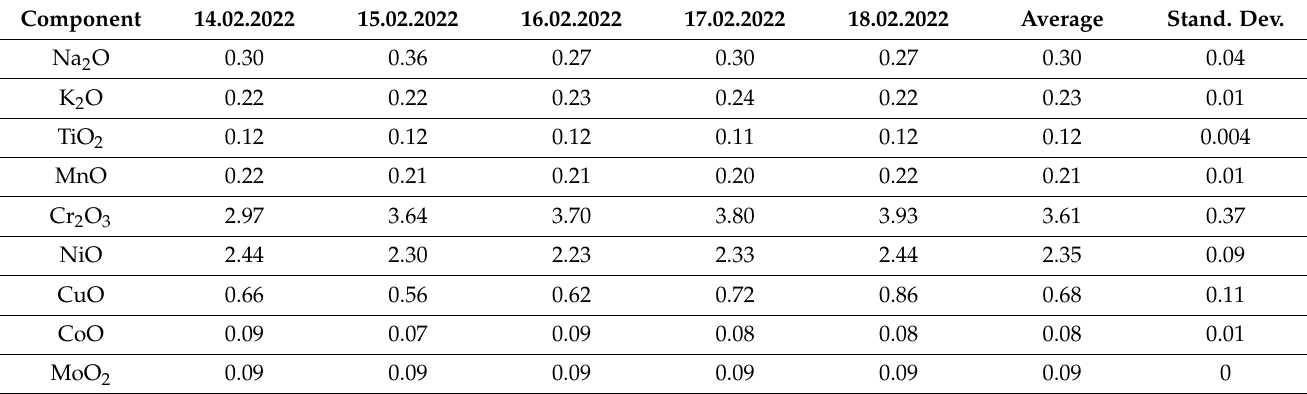
Table 2. Chemical analysis of the previously dried samples obtained by XRF spectrometry. Component